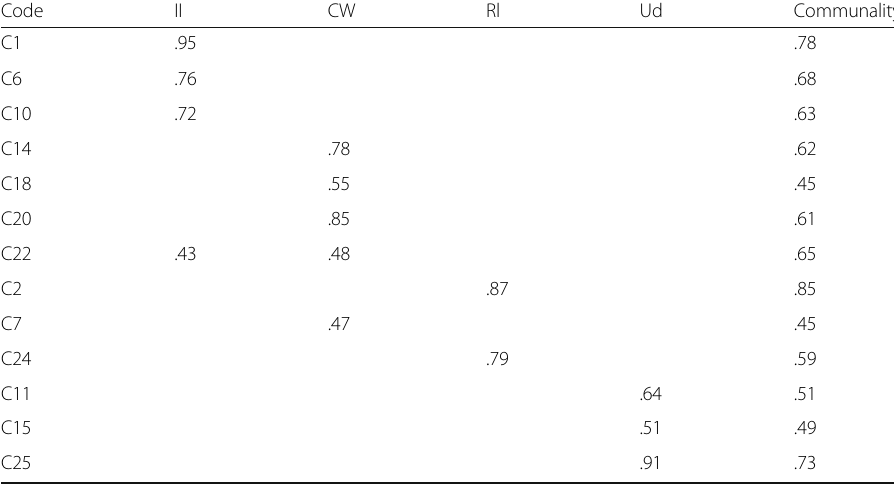
Table 4 Factor loadings and communalities for 13 items measuring deep approach ( N = 90)